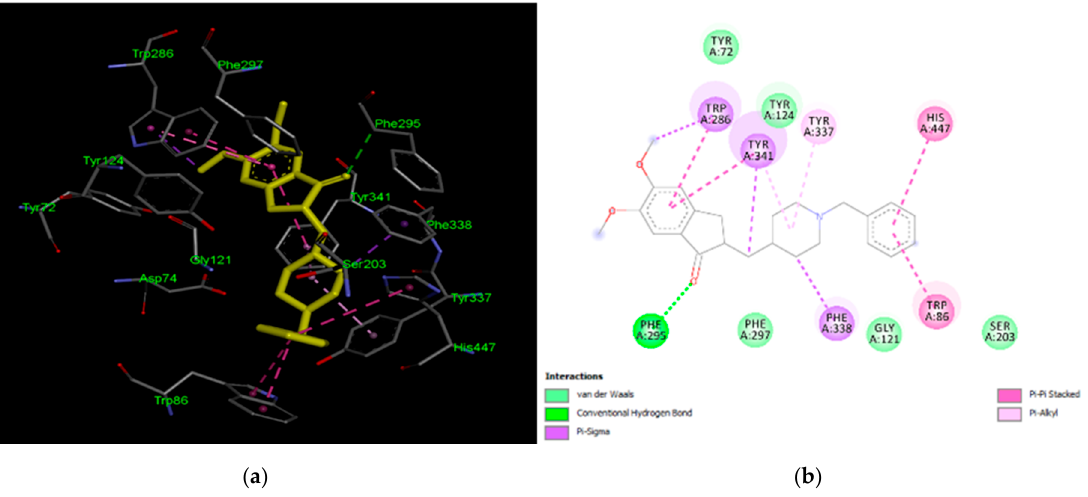
Figure 3. Active site of the AChE enzyme with donepezil: ( a ) 3D view; ( b ) 2D view. Rutin demonstrated the weakest binding affinity toward AChE among the studied ligands.